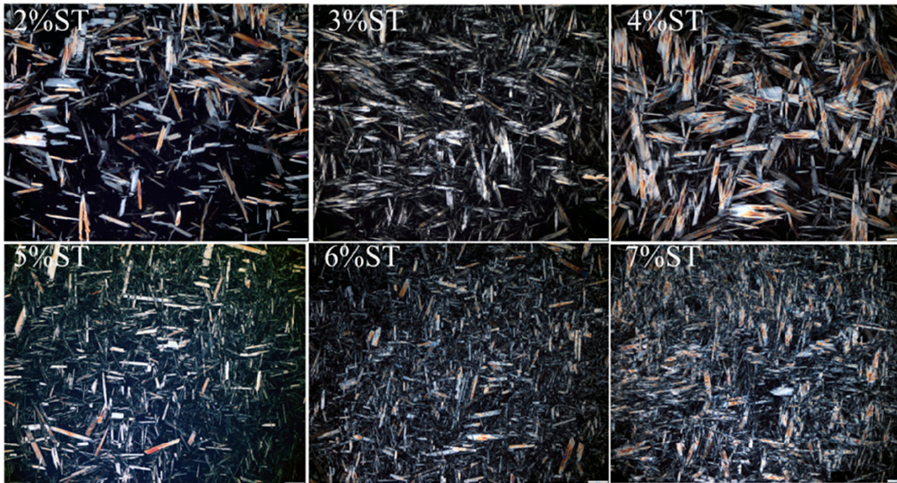
Figure 7. Microstructures of stigmasterol organogels observed at 100× after 24 h storage at 5